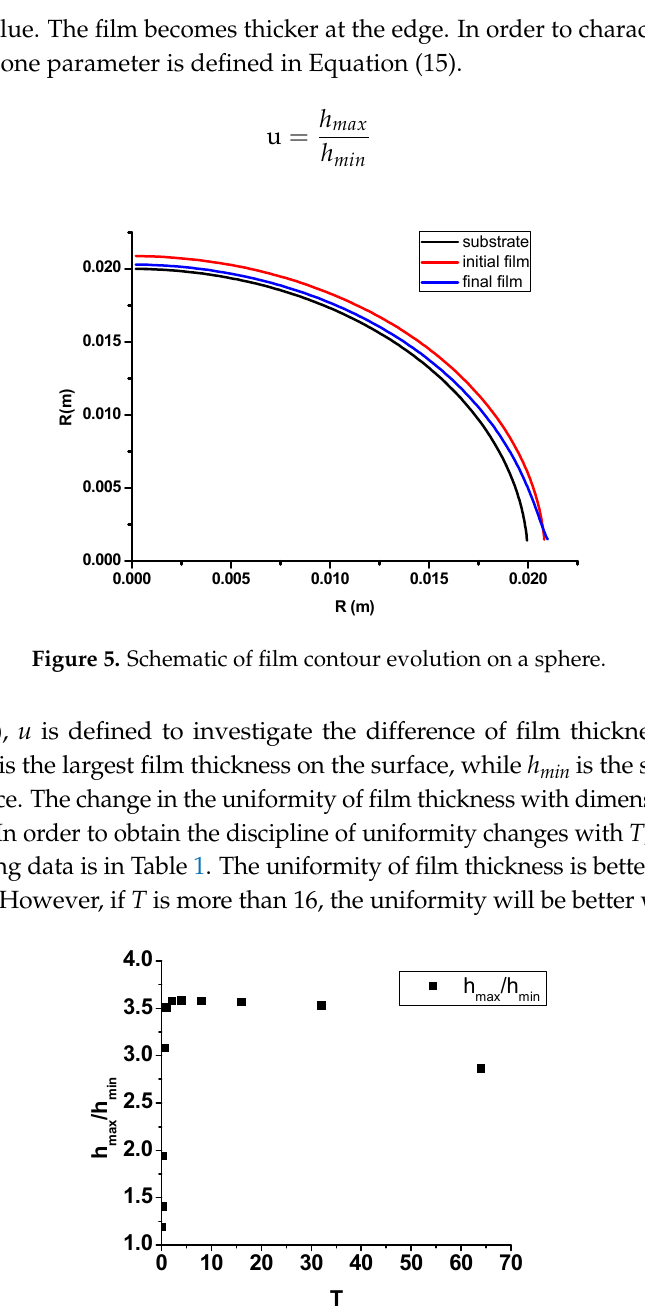
Figure 6. Change of uniformity with T . Table 1. Uniformity of film thickness at different T .